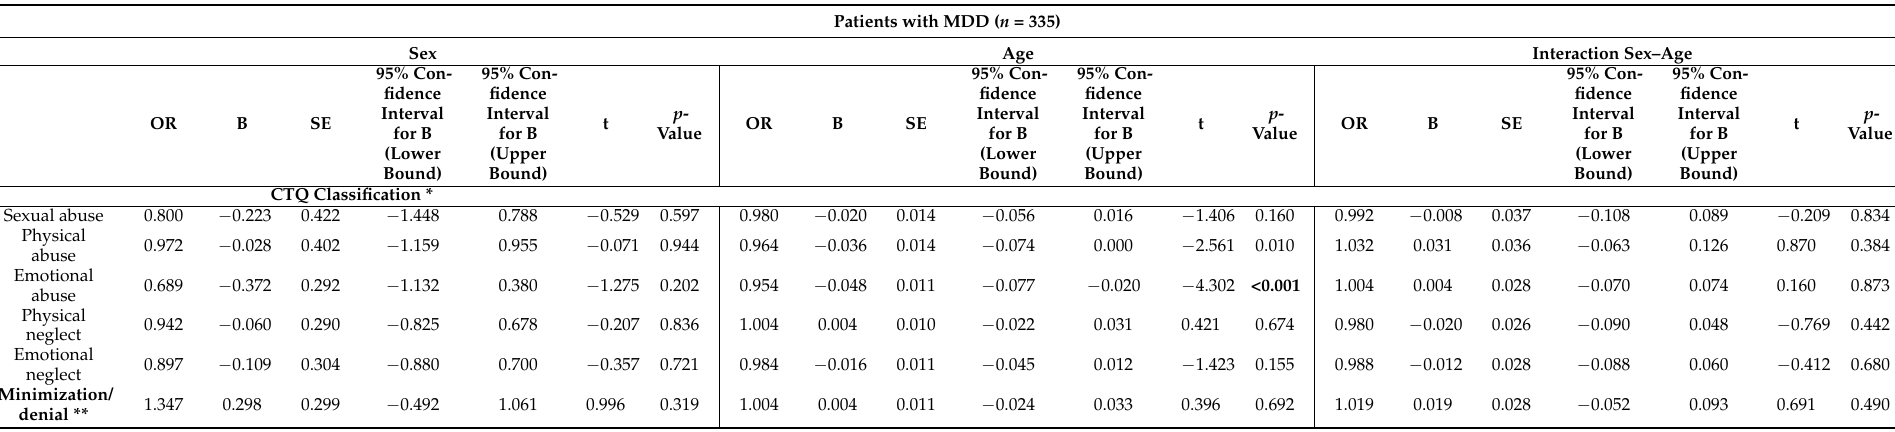
Table 3. Logistic regression analysis in patients with MDD.